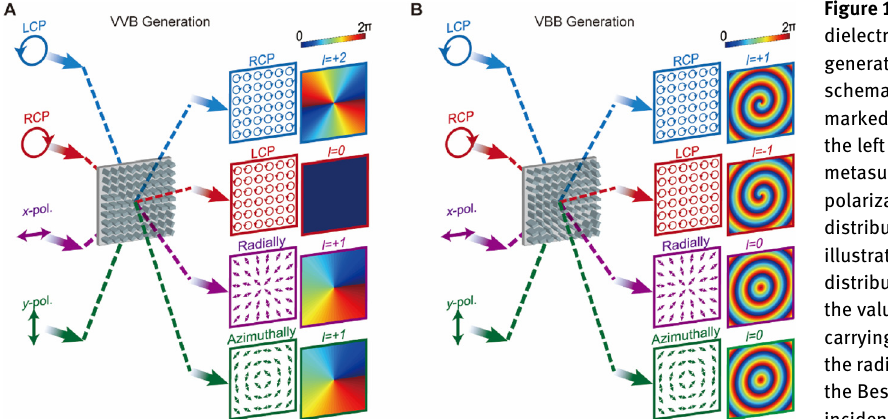
Figure 1: Schematic of CVB generation in dielectric metasurfaces. (A) VVB generation. (B) VBB generation. Each schematic contains four excitation cases marked by different colors. The arrows at the left and right sides of the two metasurfaces illustrate the incident polarizations and the output polarization distributions, respectively. The color maps illustrate the corresponding phase distributions, where the number l represent the value of the topological charge and the carrying OAM. The phase gradients along the radial direction in (B) are for generating the Bessel beams. Under the LCP and RCP